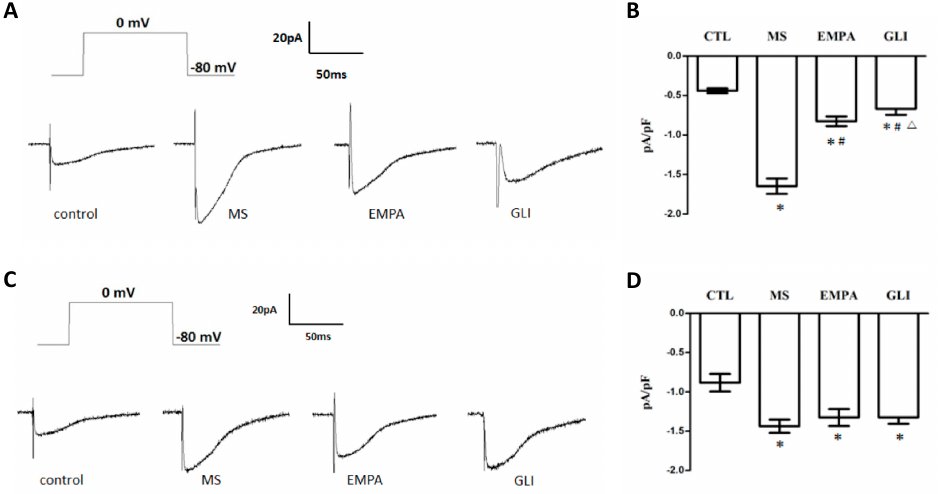
Figure 3. Effects of adipocytokines from the pericardial and peripheral fat tissues of study groups on L-type calcium channel current (I Ca,L ) in H9c2 cells. ( A ) Representative recordings of the I Ca,L evoked by applying a pulse of 0 mV for 300 ms at a holding potential of − 80 mV in H9c2 cells treated with adipocytokines from the pericardial fat of different groups for 18 h. ( B ) Bar graph showing the I Ca,L (pA/pF) averaged from the recordings of the trace ( n = 6). ( C ) Representative recordings of the I Ca,L evoked by applying a pulse of 0 mV for 300 ms at a holding potential of − 80 mV in H9c2 cells treated with adipocytokines from the peripheral fat of different groups for 18 h. ( D ) Bar graph showing the I Ca,L (pA/pF) averaged from the recordings of the trace ( n = 6) ( C ). Data are the means ± standard deviation. * p < 0.05 compared with the control. # p < 0.05 compared with the MS; △ p < 0.05 compared with the EMPA; MS: metabolic syndrome; EMPA: empagliflozin; GLI: glibenclamide.